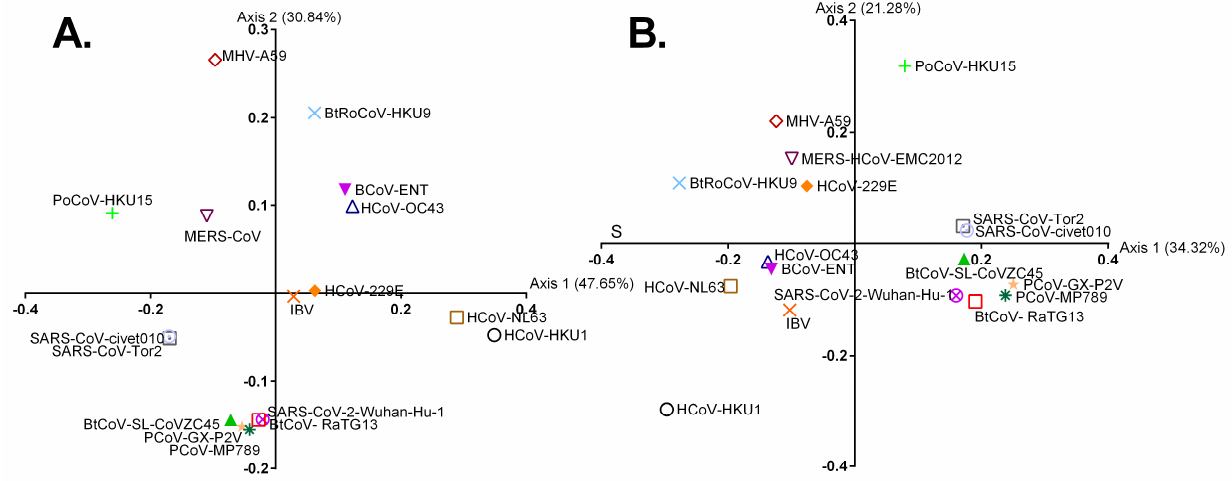
Figure 5. Correspondence analyses based on relative synonymous codon usage in the entire coding genomic sequences ( A ), spike ( B ), envelope ( C ), nucleocapsid ( D ), and membrane ( E ) encoding sequences of CoVs infecting diverse hosts.